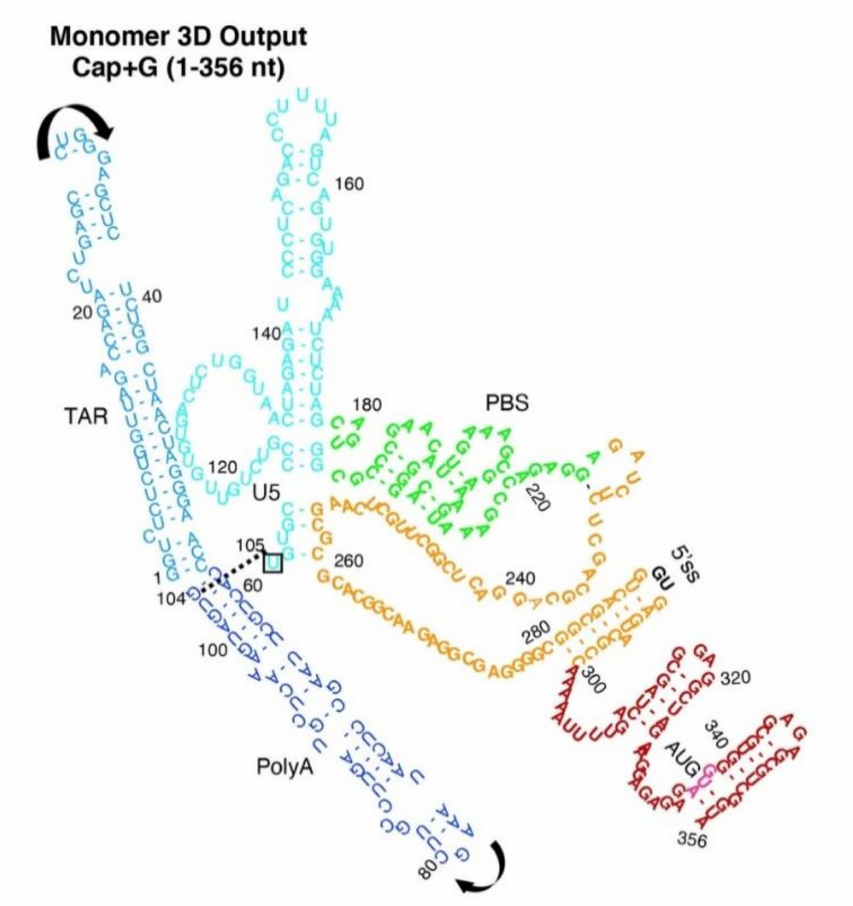
Figure 5. 2D rendering of SimRNA 3D Monomer model. Arrows represent the direction of TAR or PolyA helices. Label colors designate: TAR, light blue; PolyA, navy; U5 stem, cyan; PBS-segment, green; DIS stem, orange; AUG stem, red; 5 (cid:48) -splice site (5 (cid:48) ss), black; nt of the 3-way junction, orange. Space filling atoms: 5 (cid:48) -Cap, white; G104, yellow; U105, black; AUG translation start codon, red or